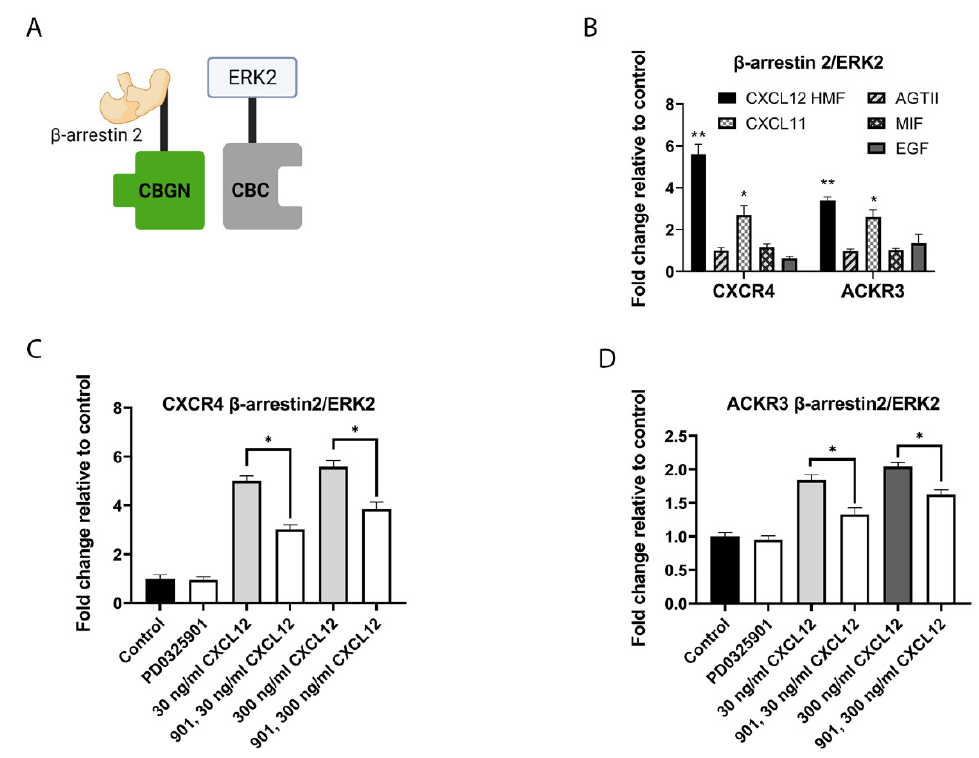
Figure 3. Modest effects of other ligands and compounds on interaction between β -arrestin 2 and ERK2. ( A )Schematic of the complementation scheme for interaction between β -arrestin 2-CBGN and ERK2-CBC. ( B ) We treated MDA-MB-231 cells stably expressing CXCR4 or ACKR3 and the complementation pair of β -arrestin 2-CBGN and ERK2-CBC with 100 ng/mL CXCL12- α ; 1 µ g/mL CXCL11, angiotensin II, or MIF; or 100 ng/mL EGF. The graph shows mean values + SEM for bioluminescence normalized to control cells not treated with CXCL12- α measured 20 min after adding a ligand. *, p < 0.05 and **, p < 0.01 relative to control. ( C , D ) We treated MDA-MB-231 cells with CXCR4 ( B ) or ACKR3 ( C ) with 100 nM of the MEK inhibitor PD0325901 (901) for one hour before treating cells with listed concentrations of CXCL12- α . We quantified bioluminescence from interaction between β -arrestin 2-CBGN and ERK2-CBC 20 min after adding CXCL12. Graphs show mean values + SEM for fold change relative to control cells. * p < 0.05 and ** p < 0.01 for matched comparisons of the same concentrations of CXCL12 without or with PD0325901. Illustration created with BioRender.com (accessed on 28 April